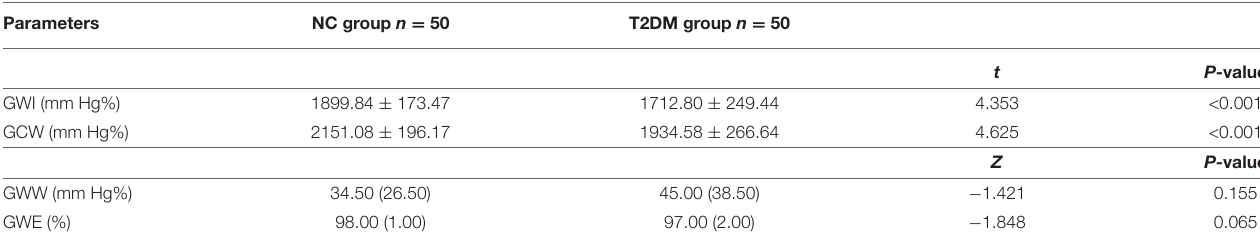
TABLE 3 | Statistical comparisons of global myocardial work parameters between NC and T2DM groups. Parameters